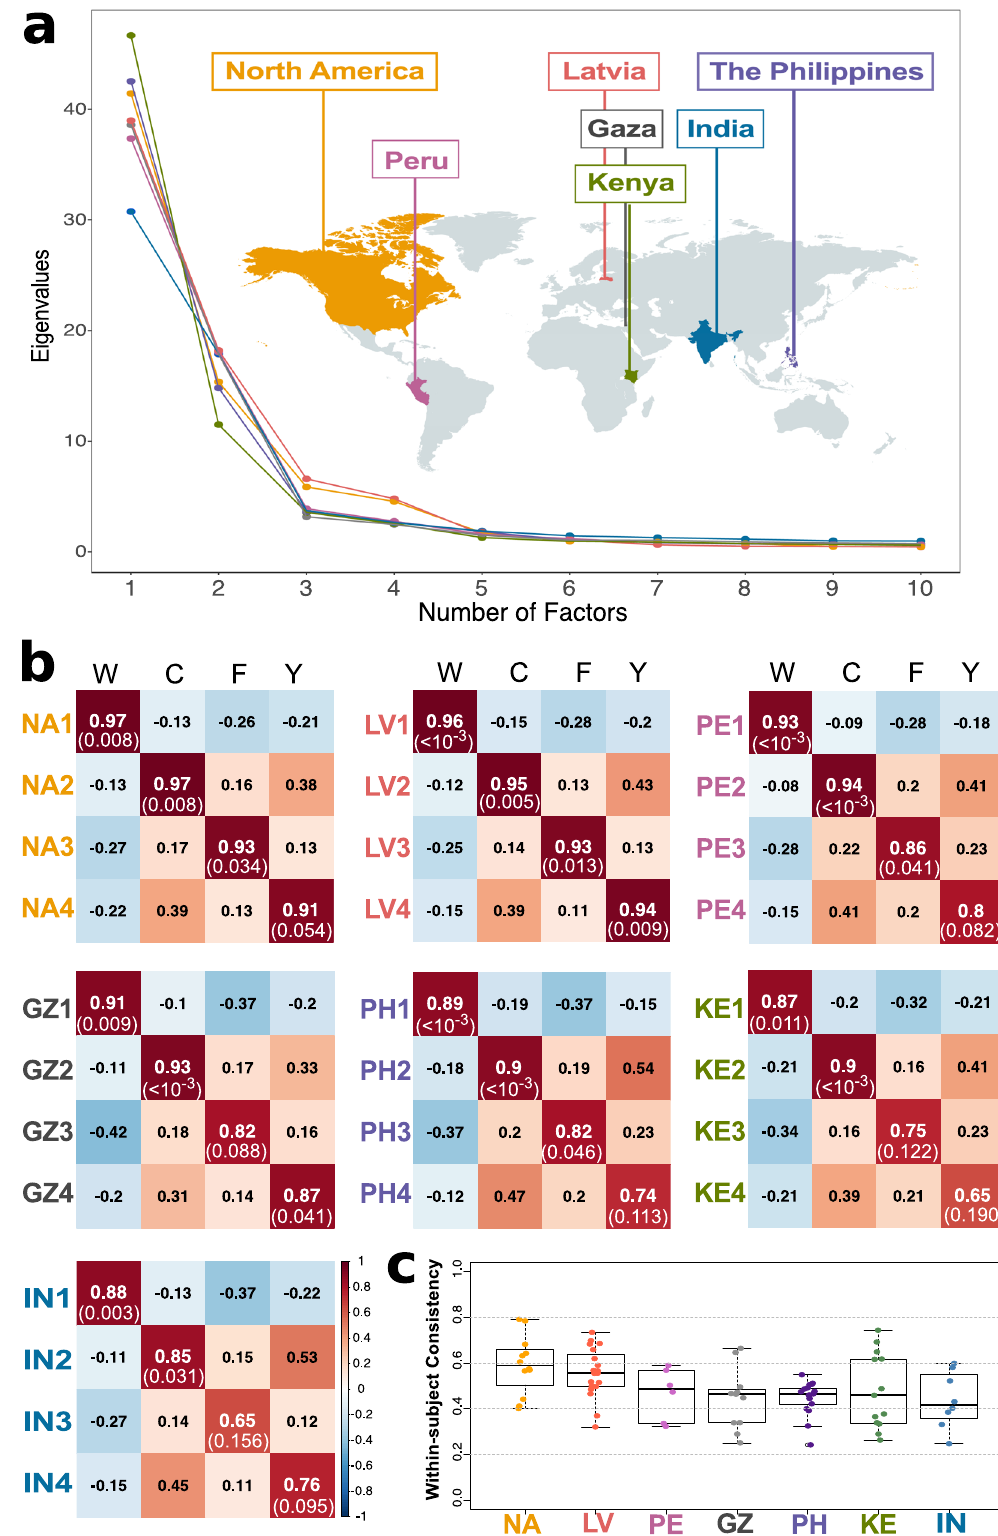
We fi rst performed RSA to investigate whether single participants ( n = 86 who had complete datasets for all traits after data exclusion; see Methods) shared the correlation structure of our Study 1 sample. RSAs varied considerably across participants (range = [0.14, 0.85], M = 0.56, SD = 0.16) and, as expected, were attenuated by within-subject consistency (Fig. 7a,